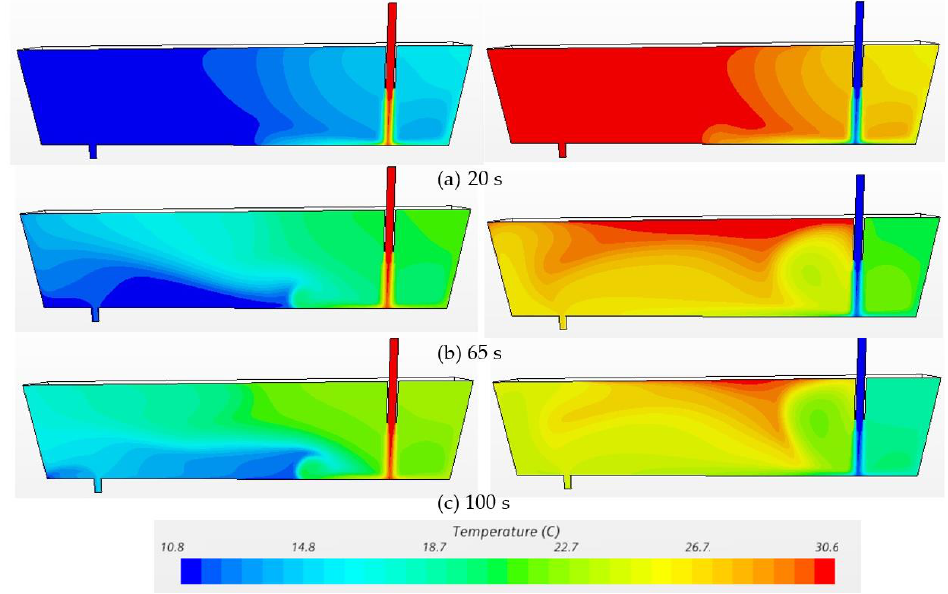
Figure 7. Temperature profiles at the symmetry plane under transient non-isothermal conditions in bare water model (Q = 2000 L/h, H = 0.4 m, left: ΔT = 20 °C, right: ΔT = −20 °C). ( a ) 20 s, ( b ) 65 s, ( c ) 100 s.